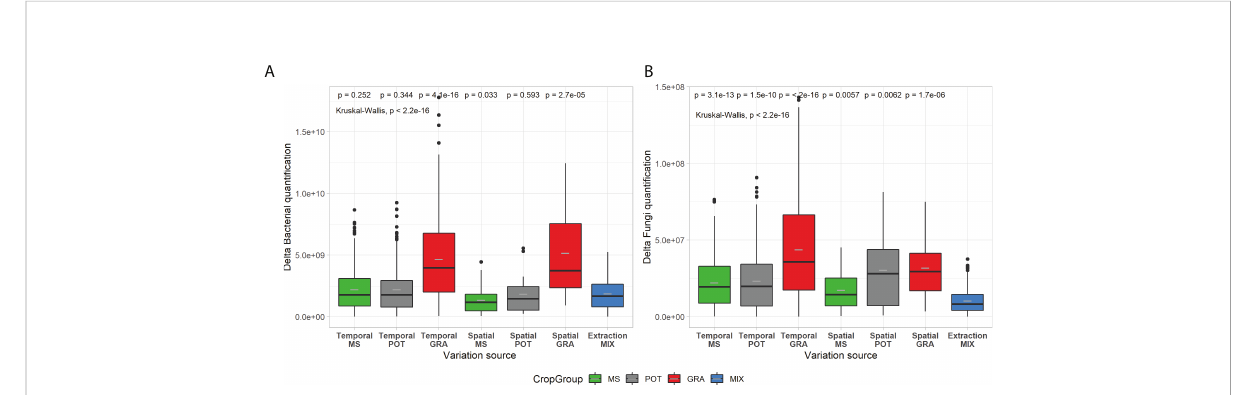
FIGURE 6 Box-and-whisker plots of microbial quanti fi cation for spatial, temporal and technical variability of prokaryotic (A) and fungal (B) communities. Boxplots are in the same format as those described in Figure 1. Crop management codes and signi fi cance codes are the same as for Figure 5.